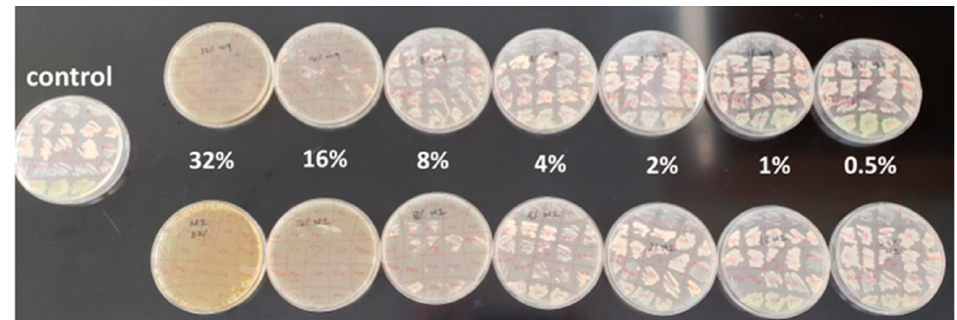
Figure 1. Example of a honey plate MIC assay. Each organism is patched onto the plates in triplicate. The MIC is defined as the lowest concentration of honey at which an organism does not grow. The three values obtained in one experiment are averaged in order to control for differences in inoculation volume that may occur in this dry patch method. Plates are Mueller–Hinton media with honey added to equal 0.5–32% honey, while the control is Mueller–Hinton media with 0% honey. Using the honey plate assay, we hypothesized that wildflower honey would be more effective as an antibacterial agent because it presumably contains a wider variety of antibac- terial botanical compounds. Since manuka honey is already a well-known FDA-approved wound treatment, we included manuka honey in this study as a comparative